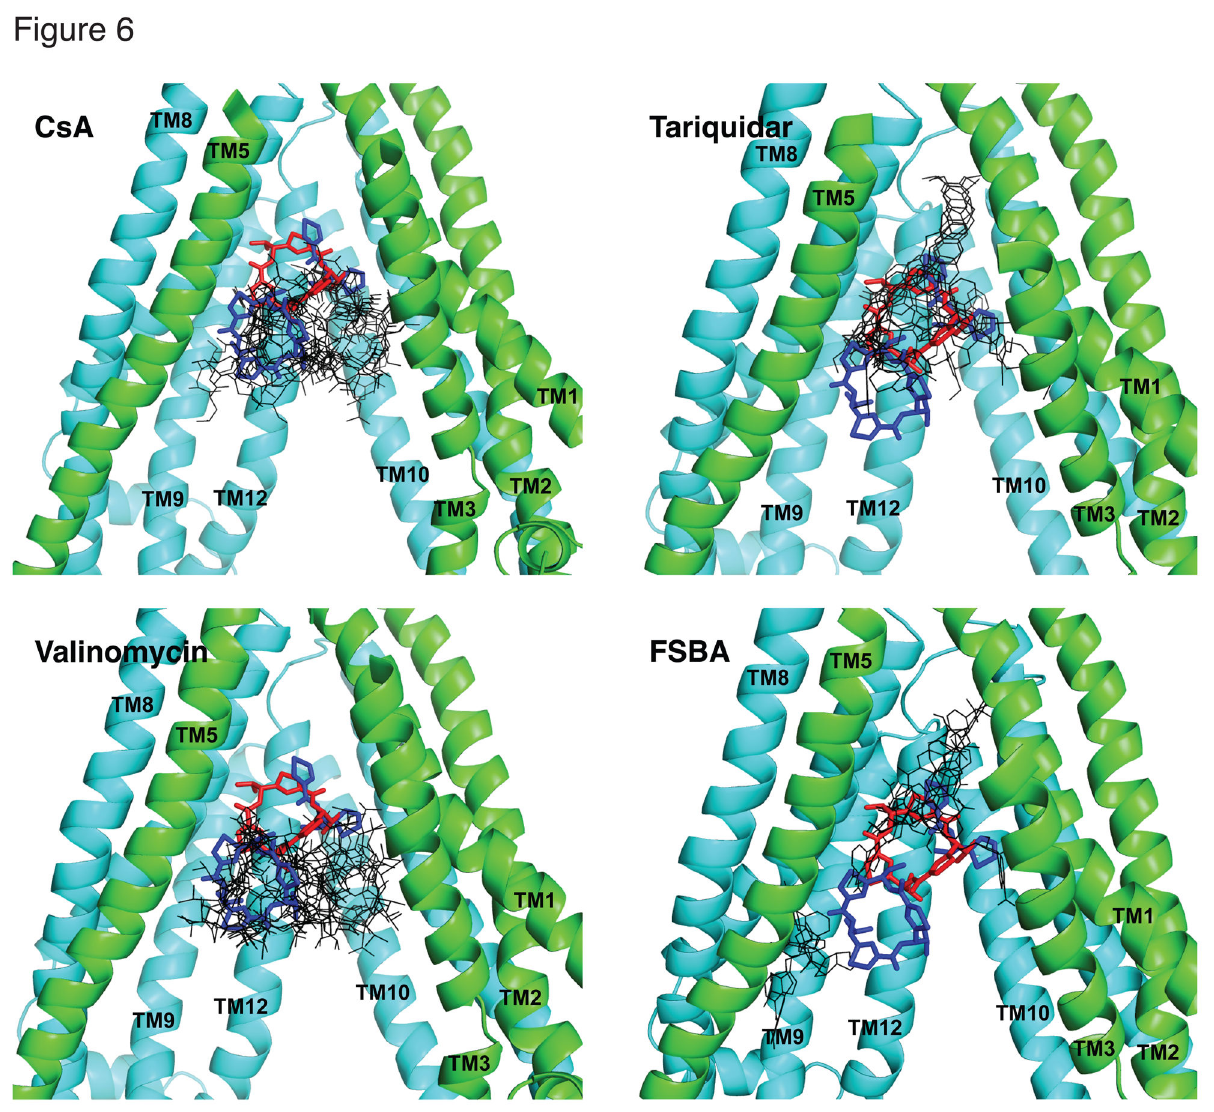
Figure 6. Docking of cyclosporine A, tariquidar, valinomycin and FSBA in the binding pocket of human Pgp. The homology model of human Pgp was generated using the recently described structure of mouse Pgp as a template (4KSB.pdb) [32]. Exhaustive ligand docking in the homology model of human Pgp was carried out using receptor grids centered at the position of the QZ59- RRR molecule (shown as red sticks), with flexible side-chains covering an ample space and a search box of dimensions 40Å × 35Å × 35Å. The first 10 modes with the highest docking scores were clustered and shown as black stick models for each drug. Docking results suggest different sites depending on the size of the molecule. QZ59- RRR (red) and QZ59- SSS (blue) molecules are included as stick models in their original positions, as indicated by the crystal structures 3G60.pdb and 3G61.pdb, respectively. Alpha-helices 4 and 5 are not shown for clarity; the rest of the helices of transmembrane domain 1 (green) and transmembrane domain 2 (cyan) are labeled and shown as cartoon models. The figure was prepared with PYMOL.